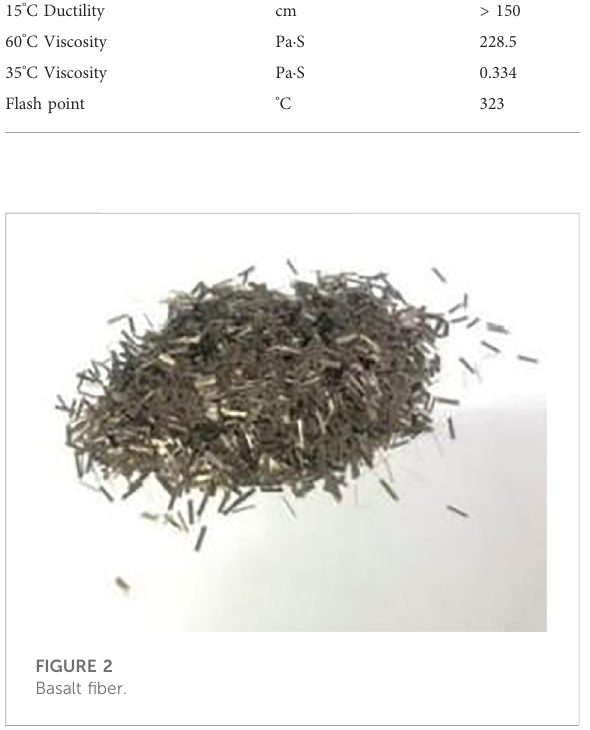
FIGURE 2 Basalt fi